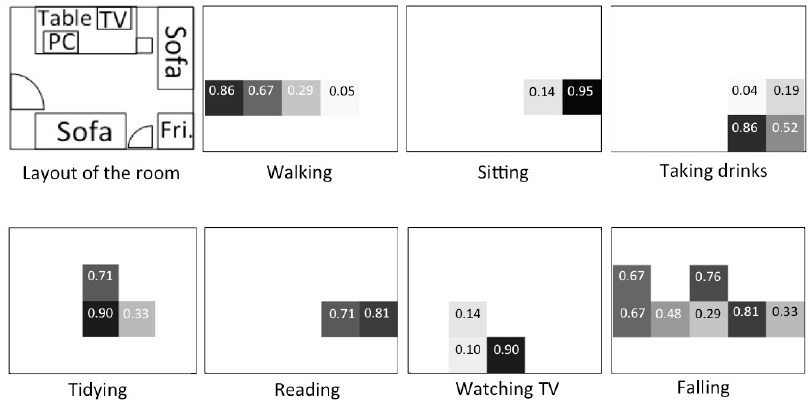
Figure 8. The variation of pixel values when a subject performs some activities. The gray level corresponds to the pixel value ( darker is higher), the decimal numbers are the pixel